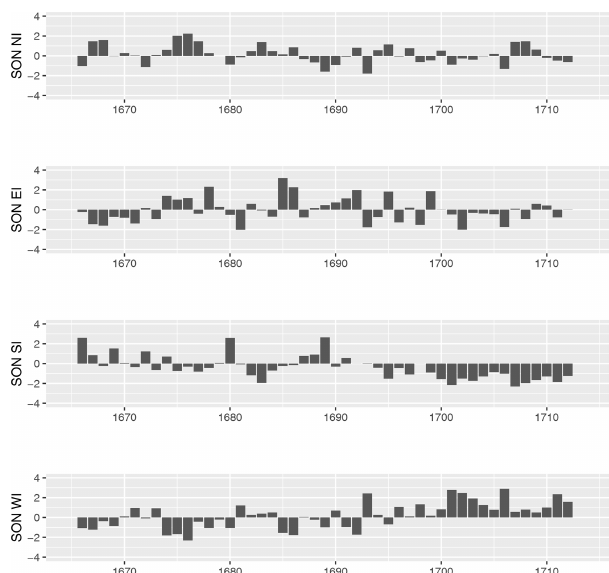
Figure A7. Standardized SON DI time series for the LMM (1665– 1713) with respect to the mean of the reference period of 1981– 2010.